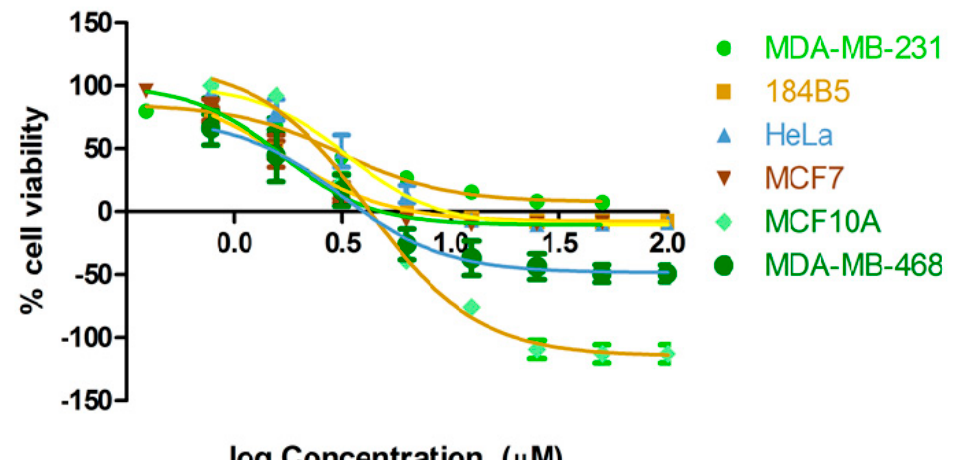
Figure 2. Anti-proliferative activity of oxostephanine ( 1 ) against cancer (MDA-MB-231, HeLa, MCF7 and MDA-MB-468) and non-cancer (184B5 and MCF10A) cells. Dose response curves are obtained from 72 h treatment and staining with SRB .